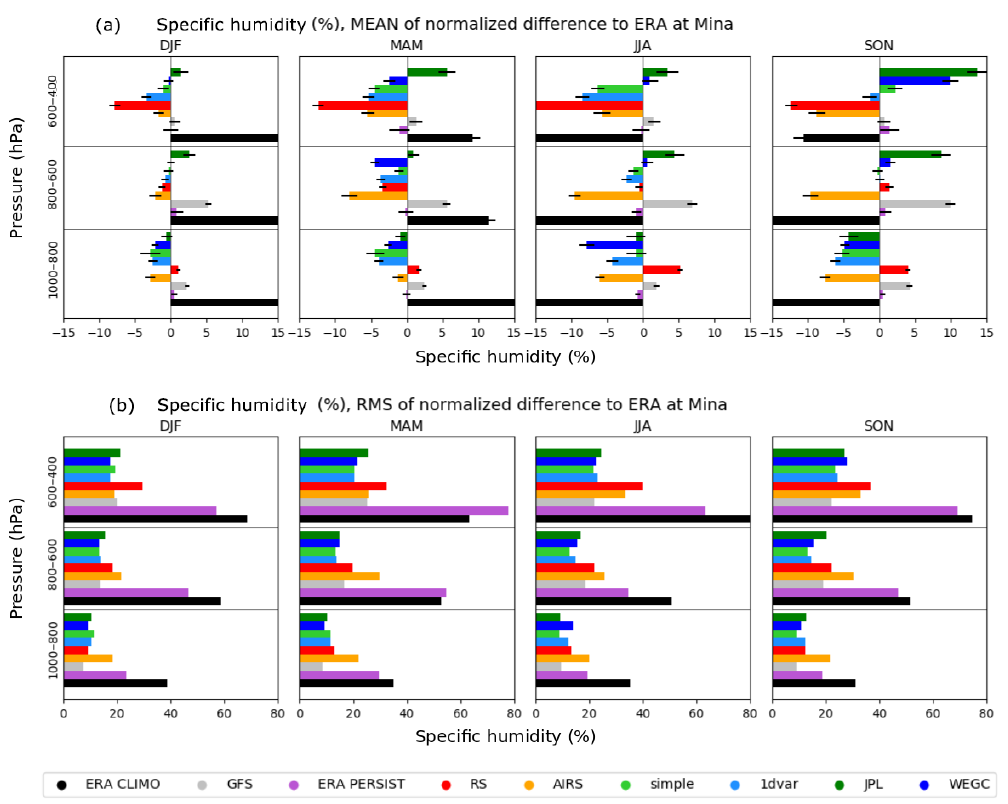
Figure 7. Mina: Mean (a) and rms (b) of the q normalized difference for all data sets, three pressure layers, and four seasons